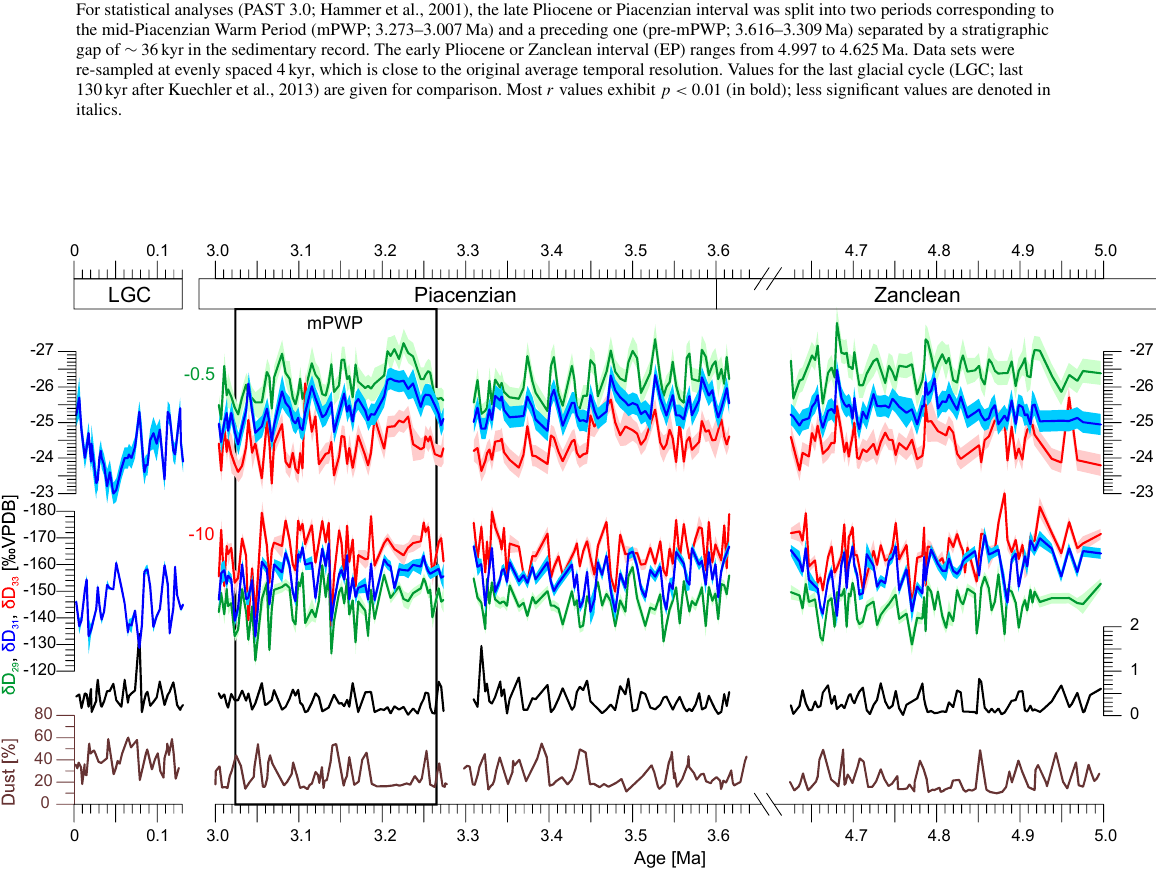
Figure 4. Results. (a–c) Stable carbon ( δ 13 C) and hydrogen ( δ D) isotope compositions of C 29 -C 33 n alkanes in per mil vs. Vienna Pee Dee Belemnite (VPDB) and Vienna Standard Mean Ocean Water (VSMOW), respectively; n alkane C 27 –C 35 concentrations in microgram per gram dry sediment, and dust percentage after Tiedemann (1991) against time in millions of years (Ma). Age model after Clemens (1999). For visibility, δ 13 C 29 values (green) are shifted minus 0.5‰ and δ D 33 values (red) minus 10‰. Results of the C 31 n alkane for the last glacial cycle (LGC) from Kuechler et al. (2013) are plotted to the left for comparison. mPWP: mid-Piacenzian Warm